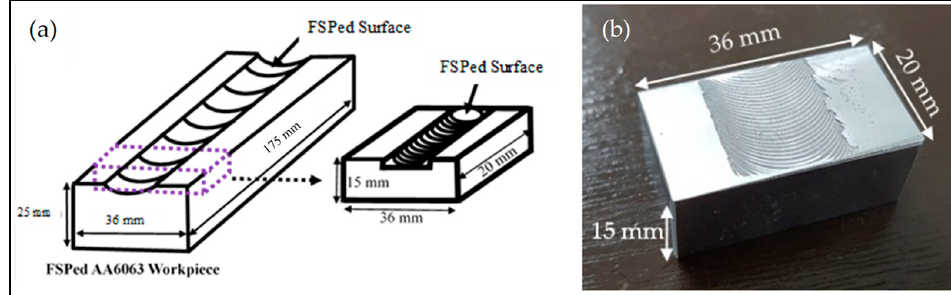
Figure 5. ( a ) Demonstration of test sample cut from the FSPed workpiece [10] and ( b ) actual image for microstructure and surface microhardness sample.